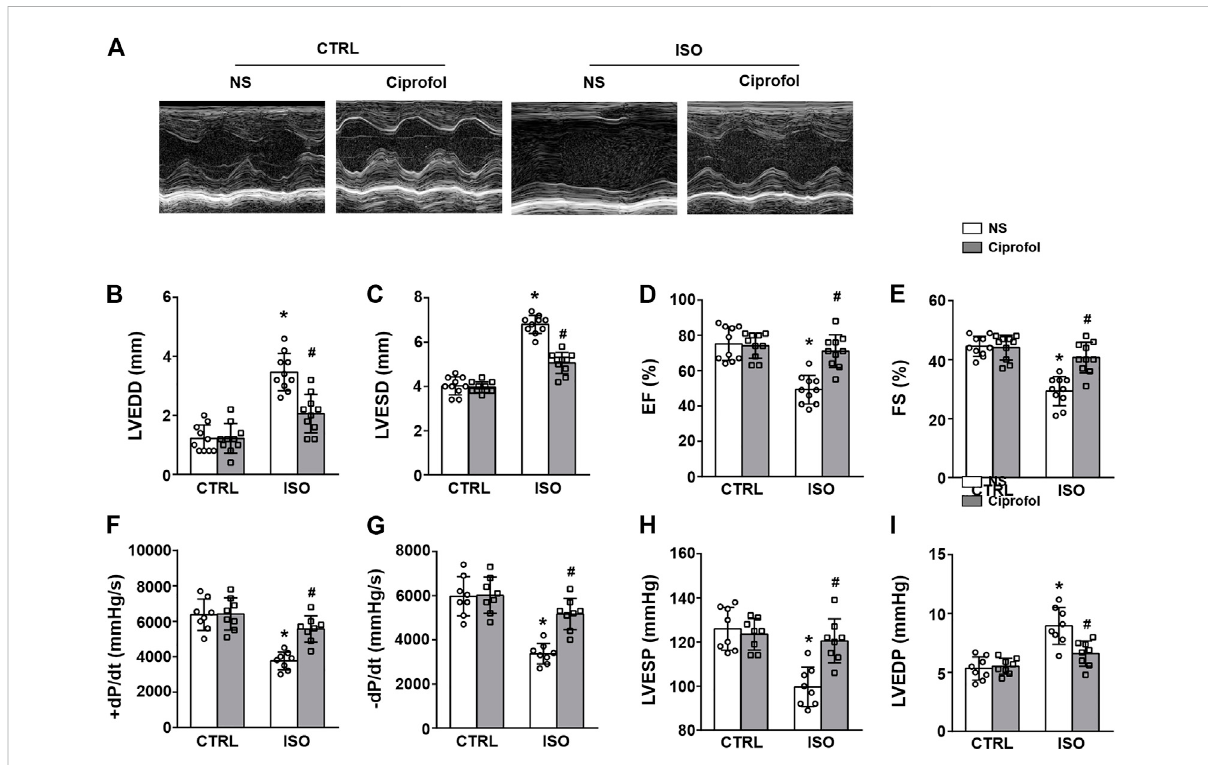
FIGURE 2 Ciprofol treatment improved ISO-inducedcardiacdysfunction. (A) Echocardiography images from eachgroup. LVEDD (B) , LVESD (C) , LVEF (D) and LVFS (E) in each group were measured ( n = 10). +dP/dt (F) , -dP/dt (G) , LVESP (H) and LVEDP (I) in each group were measured ( n = 8). p p < 0.05 compared to the CTRL group. # p < 0.05 compared to the ISO